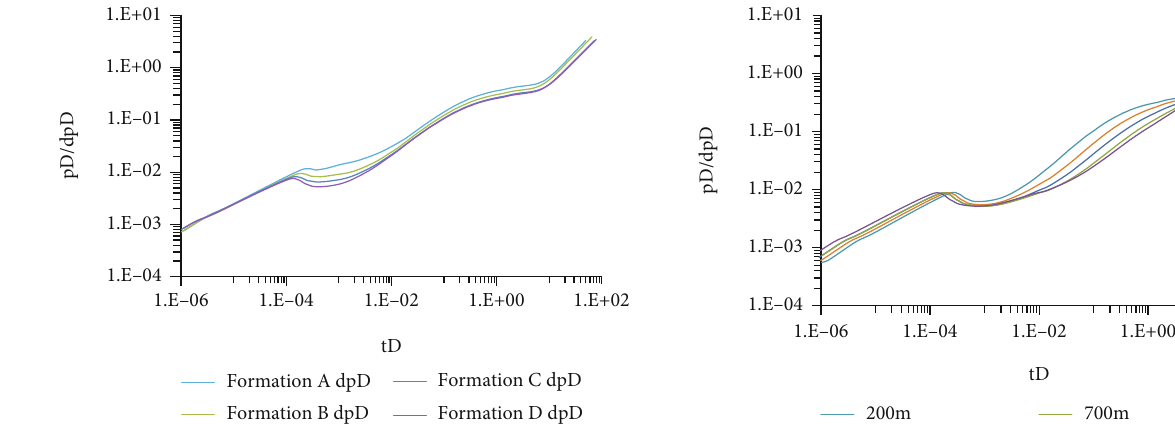
Figure 7: Comparison of dimensionless derivative pressure for the four reservoirs. Table 2: The combinations of k